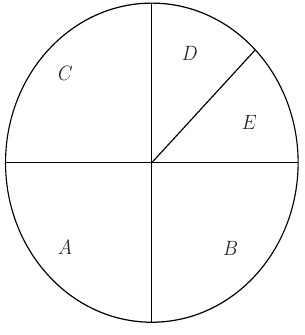
Figure 3. The relationships between the left transposition regular TA-groupoids and the quasi- separative